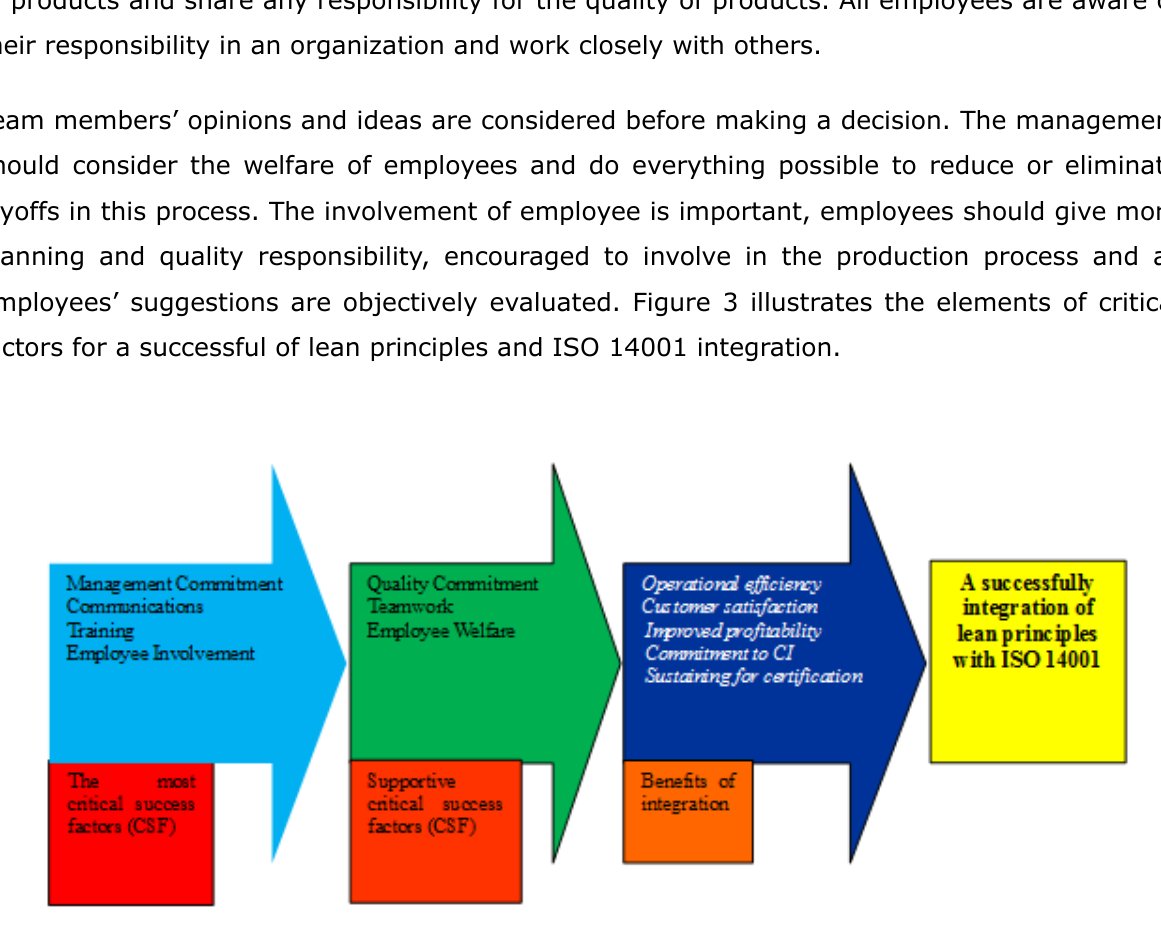
Figure 3. Elements of critical factors for a successful of lean principles and ISO 14001 integration